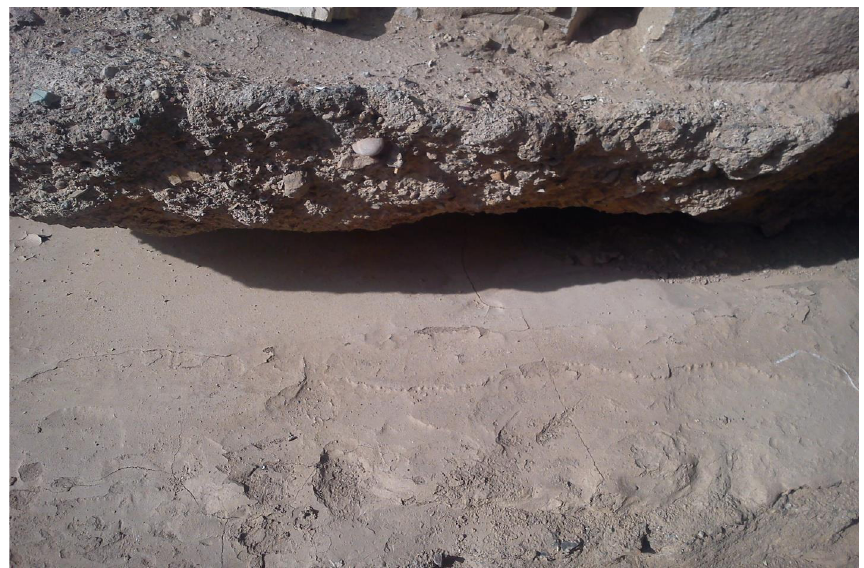
Figure 22. Bridge scour in bridge No. 5.